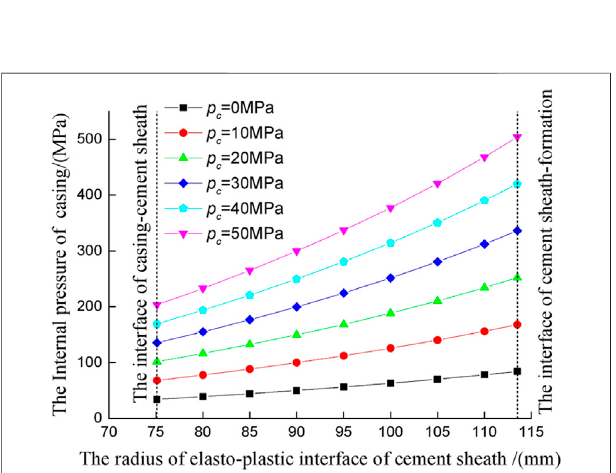
FIGURE 4 | Relationship between the elastoplastic interface and casing pressure.